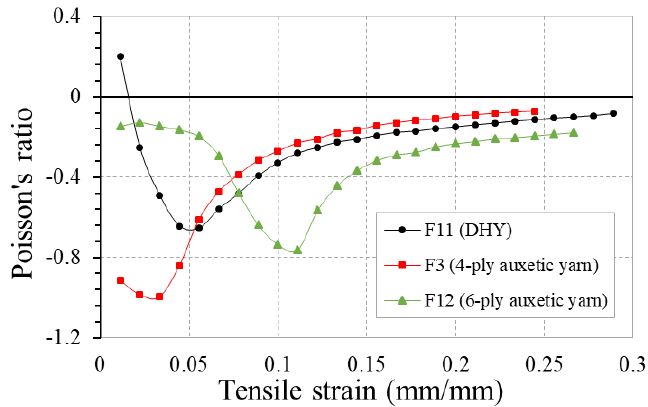
Figure 21. PR-tensile strain curves of fabrics F11, F3 and F12 made of auxetic yarns with different helical structures.